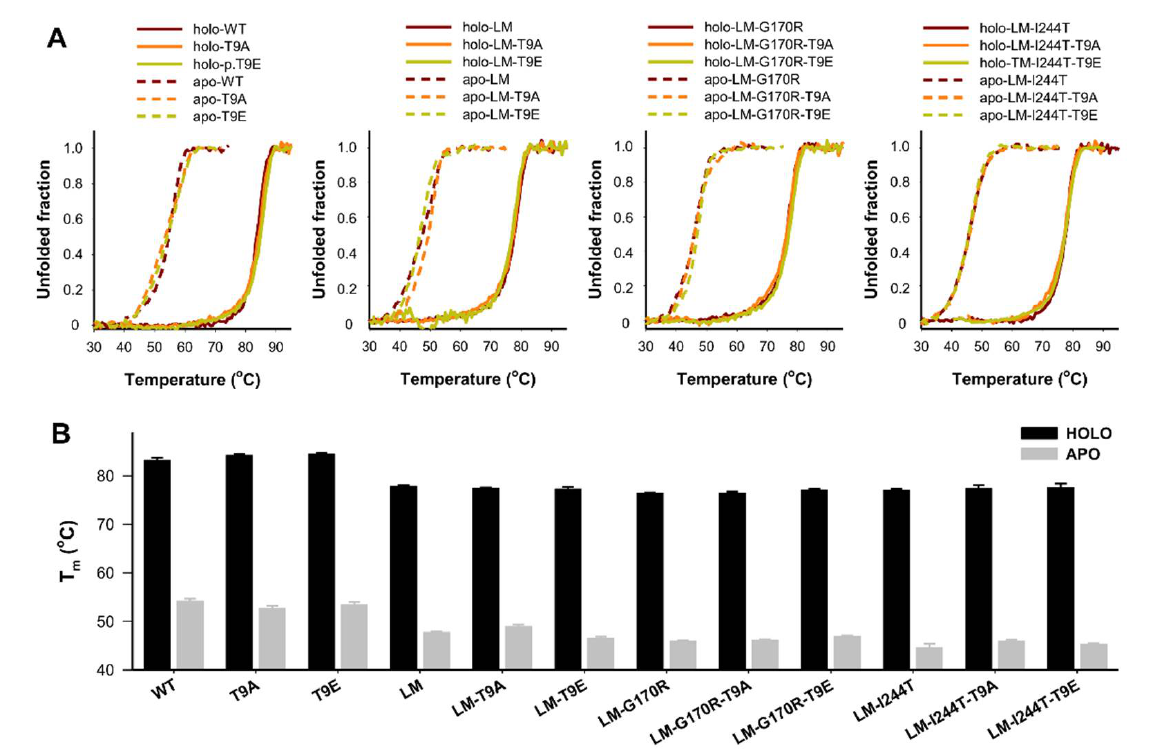
Figure 8. Thermal stability of apo- and holo-AGT variants (WT, LM, LM-G170R, and LM-I244T) in the absence or presence of the T9A or T9E mutations. ( A ) Thermal denaturation profiles monitored by intrinsic emission fluorescence; ( B ) Average ( ± s.d.) for half-denaturation temperatures ( T m values) from at least four replicas for each variant. Experiments were performed in HEPES-NaOH 20 mM, NaCl 200 mM, pH 7.4, and 25 °C. Protein concentration was 2 µM (in protein subunits).